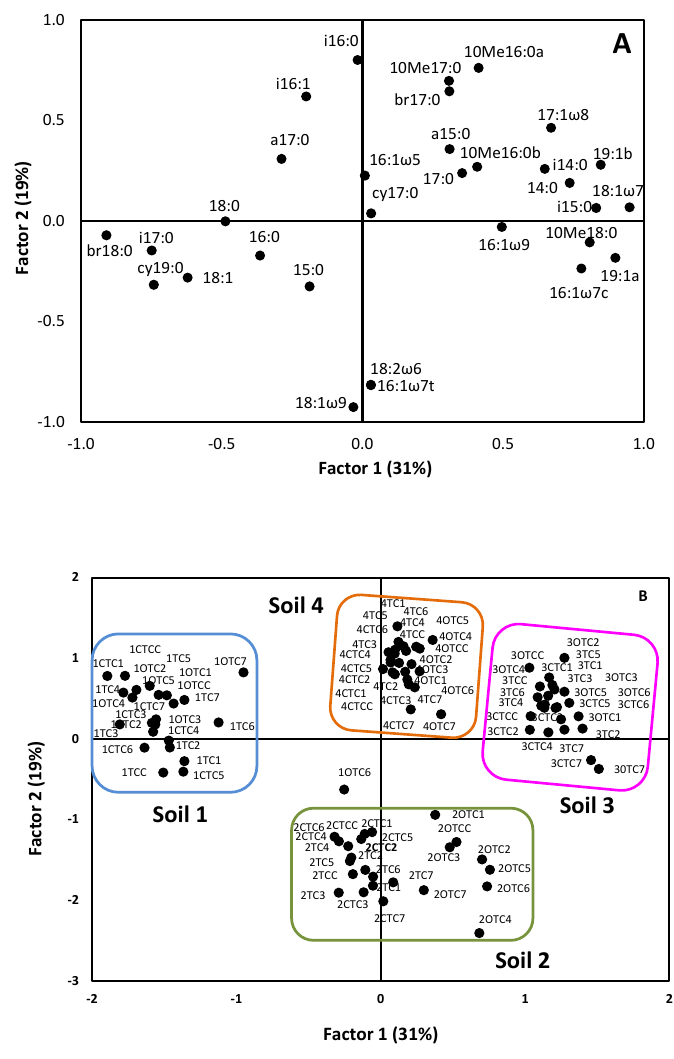
Figure 2. Principal component analysis ( A , variables; B , samples) performed with the whole PLFA dataset for the four soils studied (1, 2, 3 and 4) with eight different concentrations (0.00 (C), 0.49 (1), 1.95 (2), 7.81 (3), 31.25 (4), 125 (5), 500 (6), and 2000 (7) mg·kg − 1 soil) of the tetracycline antibiotics (CTC, chlortetracycline; TC, tetracycline; OTC, oxytetracycline) 42 days after application.